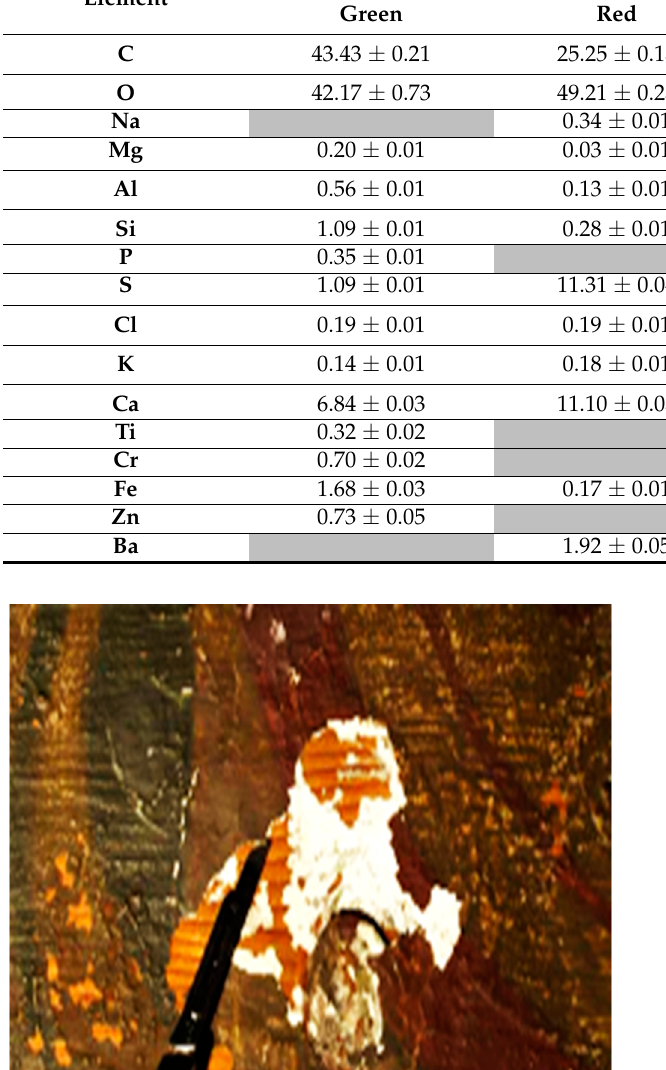
Table 2. The elemental analysis (WDXRF) of the investigated pictural layers. Element